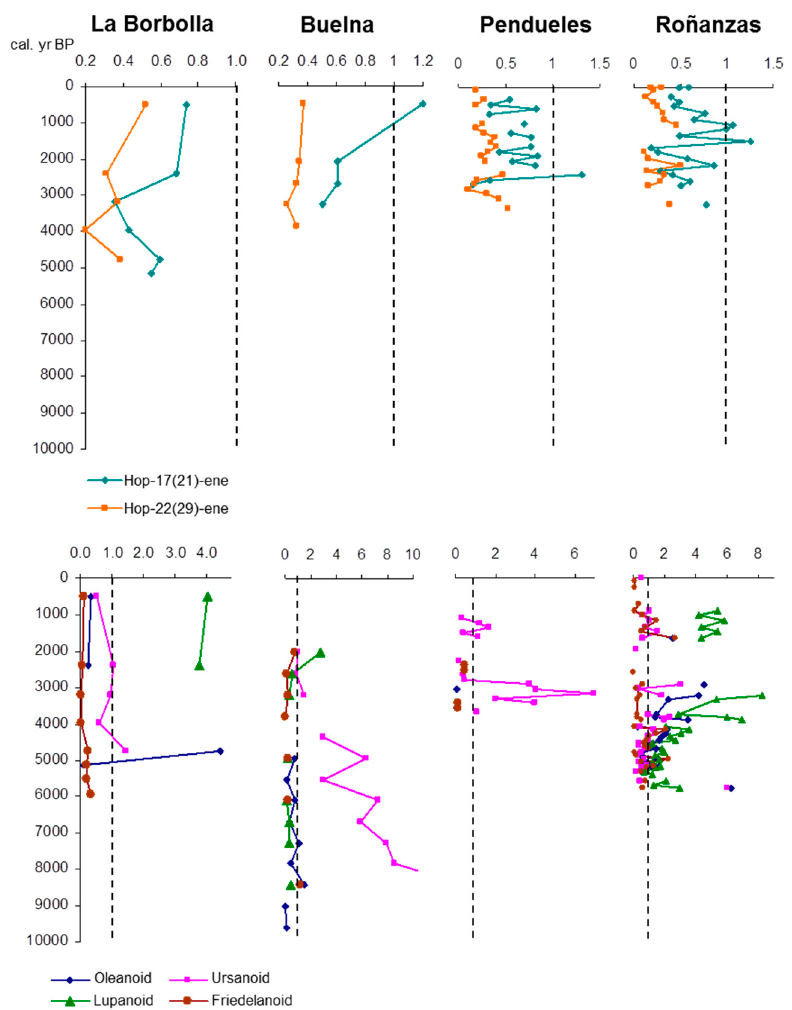
Figure 9. Variation of the acetate / ketone ratio with age for each family of compounds in the studied peat profiles.